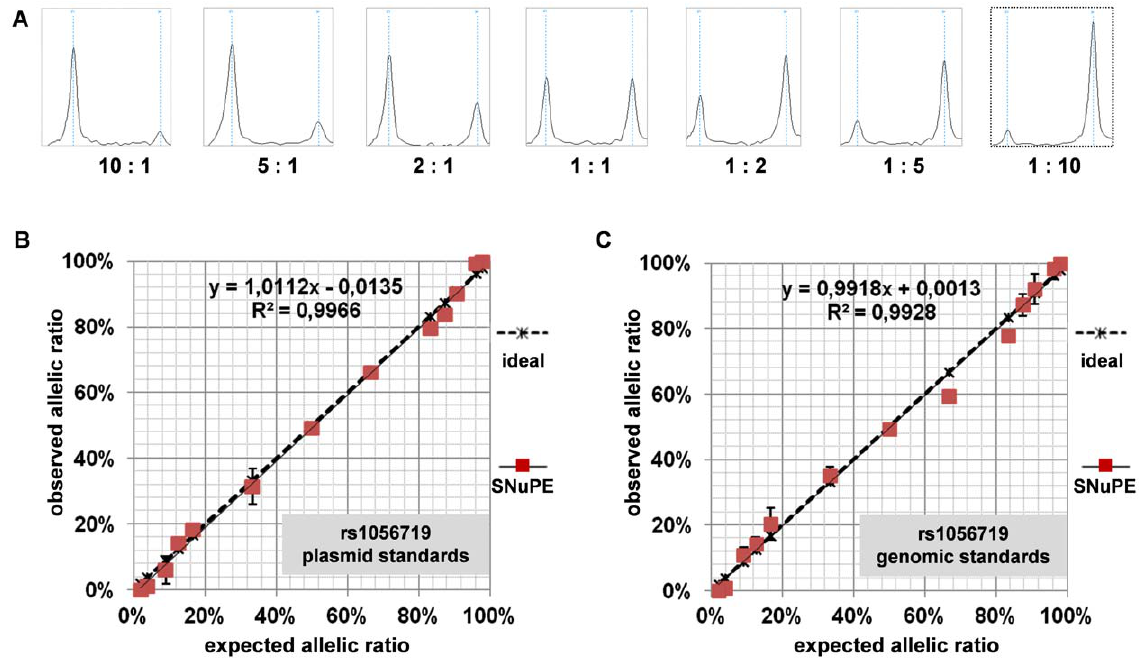
Figure 1. Characterization of a multiplexed MassARRAY-based method for detection of allele-specific expression (ASE). (A) Representative MassARRAY spectra of molecular standards of DAPK1 exonic SNP rs1056719 (G/A). Each spectrum represents the mass range from 5390 to 5500 Da displaying SNP rs1056719 out of a multiplexed assay. Left peaks represent the G allele, right peaks represent the A allele. Copy number ratios between standard plasmids containing G and A alleles are given below each spectrum. (B) Standard curves for a plasmid-based standard displaying allelic ratios from 1:50 to 50:1 and correlation with idealized ratio (SNP rs1056719). The correlation was calculated using the Pearson correlation coefficient. (C) Standard curves for a genomic DNA based standard displaying allelic ratios from 1:50 to 50:1 and correlation with the idealized ratio (SNP rs1056719).